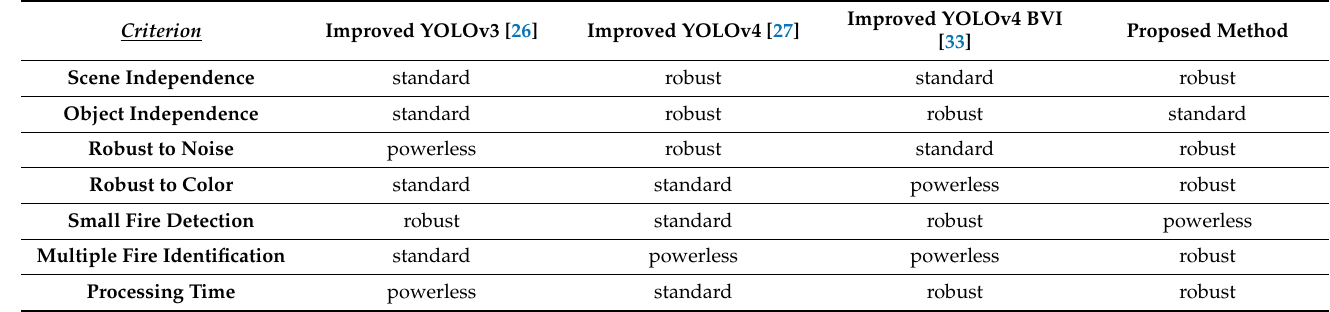
Table 3. Employing many characteristics to evaluate the effectiveness of fire